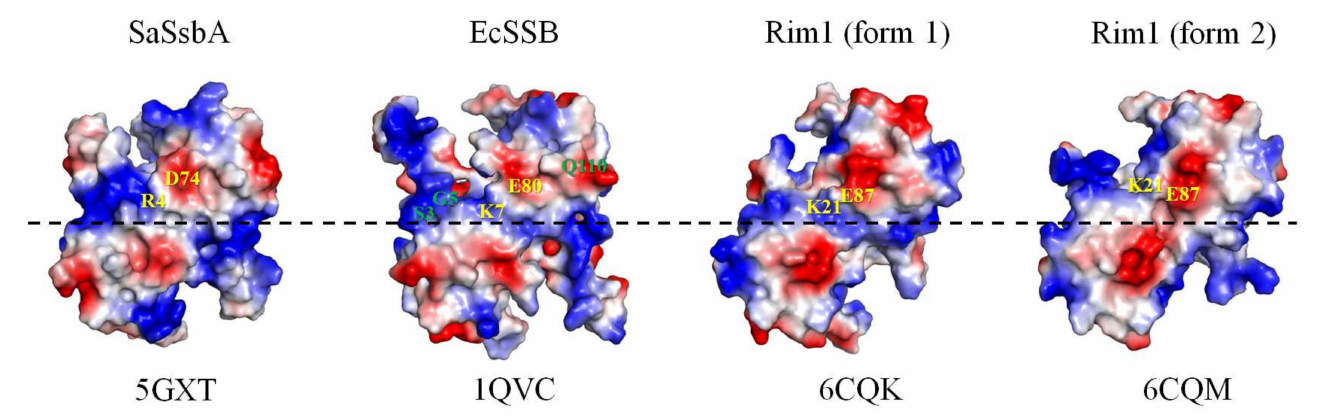
Figure 7. The electrostatic potential comparison of the dimer-dimer interfaces of SaSsbA, EcSSB, and Rim1. The important pair of charged residues (K7/E80) forming a cluster of intermolecular salt bridges at the tetramer formation surface in EcSSB is shown. This pair was also found in SeSSB, but the distance of these corresponding residues in SeSSB was too far (>4.5 Å) to efficiently interact with each other. Rim1 (the form 2) is also present in the case of SeSSB. Residues crucial for tetramerization in SeSSB are colored in green. The pair of charged residues is in